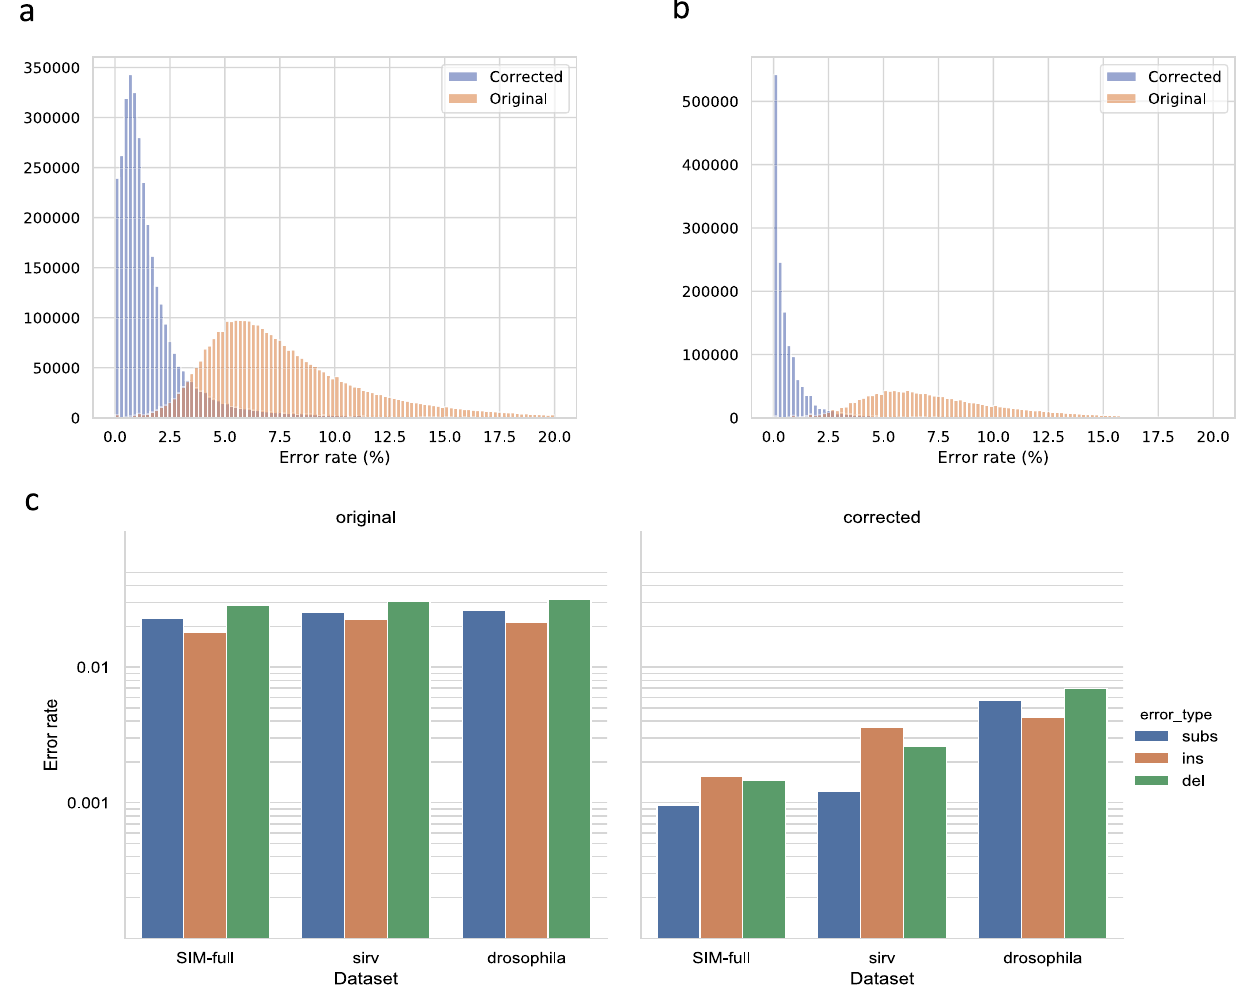
Fig. 1 Error rates of ONT reads before and after error correction. a Alignment difference distribution of corrected and original Drosophila reads. Differences can arise both from sequencing errors and variation to the reference genome. b Error rate distribution of corrected and original SIRV reads, for the whole SIRV dataset. c Error pro fi les of the datasets before and after correction (error rate), shown on a log scale. The error rate is derived from summing up the total number of respective errors divided by the total aligned length. For Drosophila, the difference to genome is treated as an error rate in this